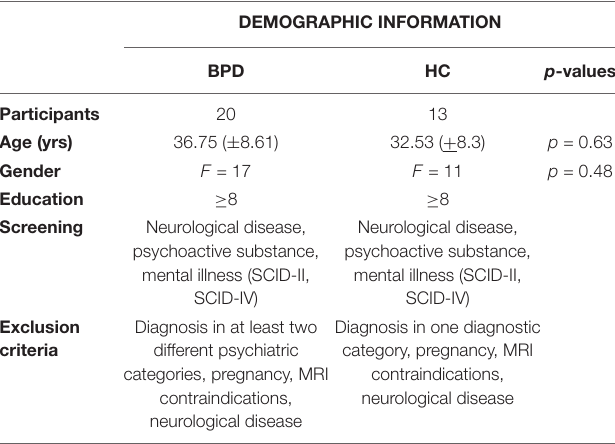
TABLE 1 | Demographic information about participants. Values in round brackets are the standard